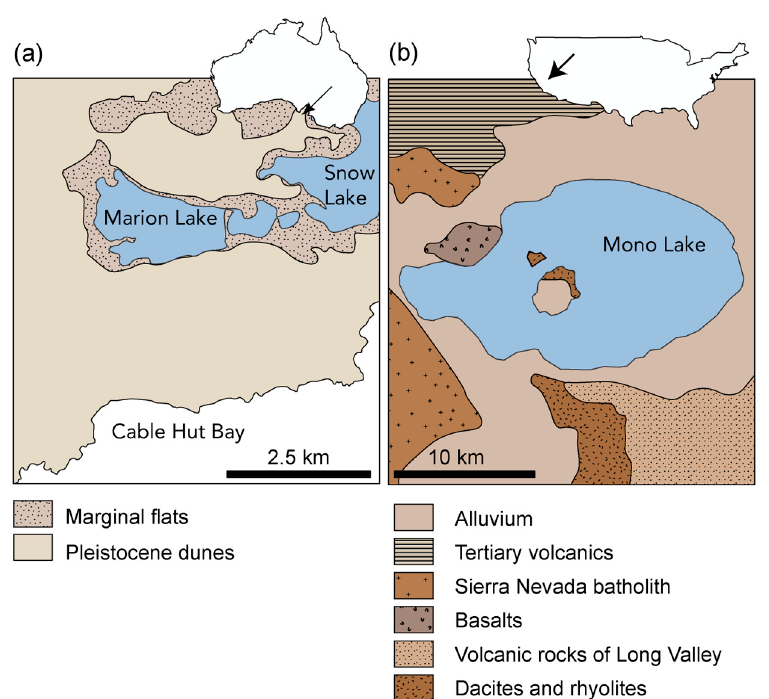
Figure 2. Maps of ( a ) Marion Lake (Yorke Peninsula in South Australia, Australia) and ( b ) Mono Lake (CA, USA) indicating the geological background. The maps are modified after [24,44].